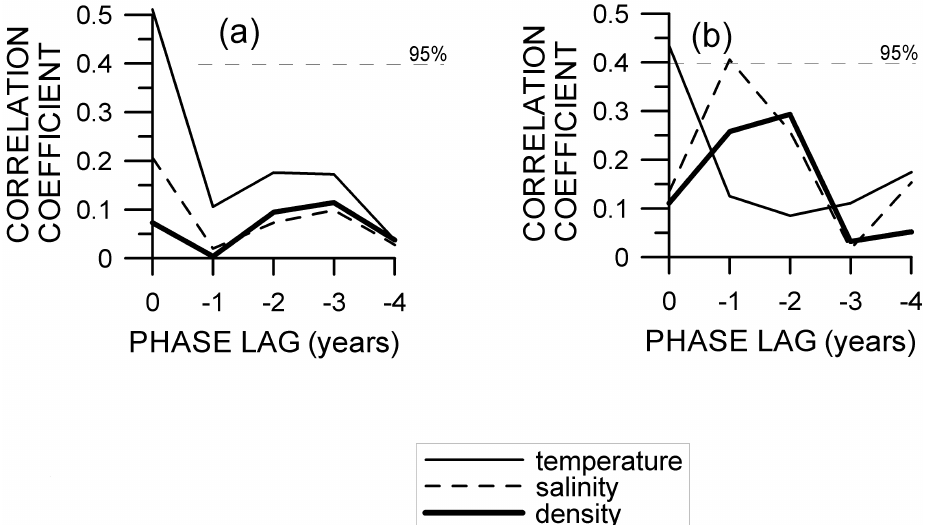
Fig. 6. Absolute values of correlation coefficients between 20 yearly means of temperature, salinity and density in the surface (a) and the bottom (b) layer at station RV001 and yearly means of Qs in the 1917–2000 interval for phase lags of 0, − 1, − 2, − 3 and − 4 years.